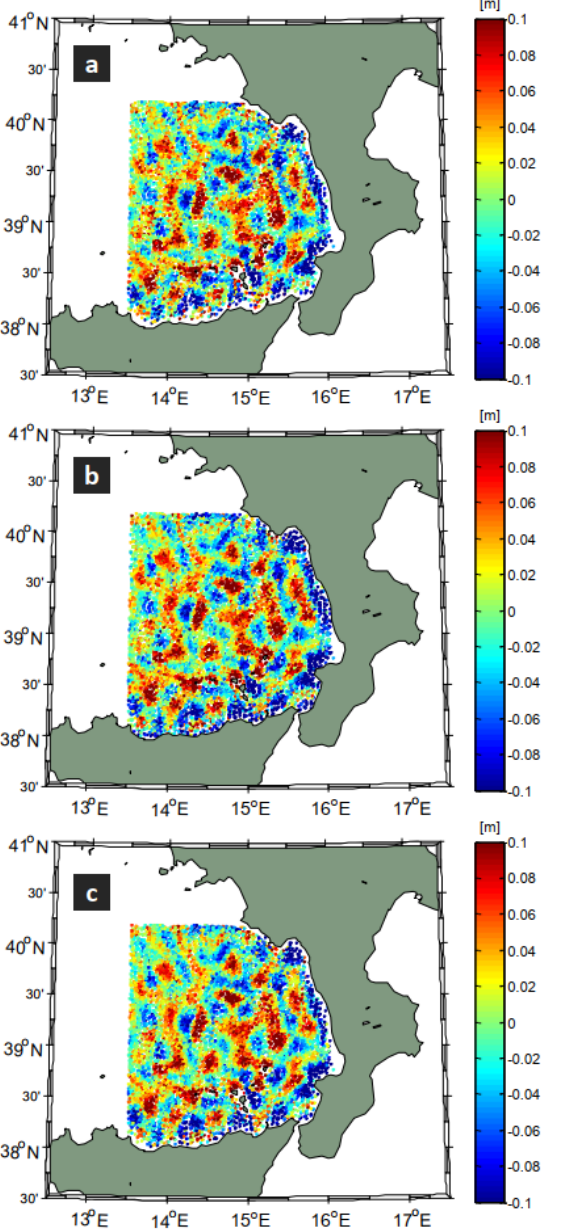
Fig. 4. Empirical covariances (* symbols) and covariance model fits (blue continuous curves) for residual height anomalies shown in Fig.3 (a) RADS (b) LARS (c)